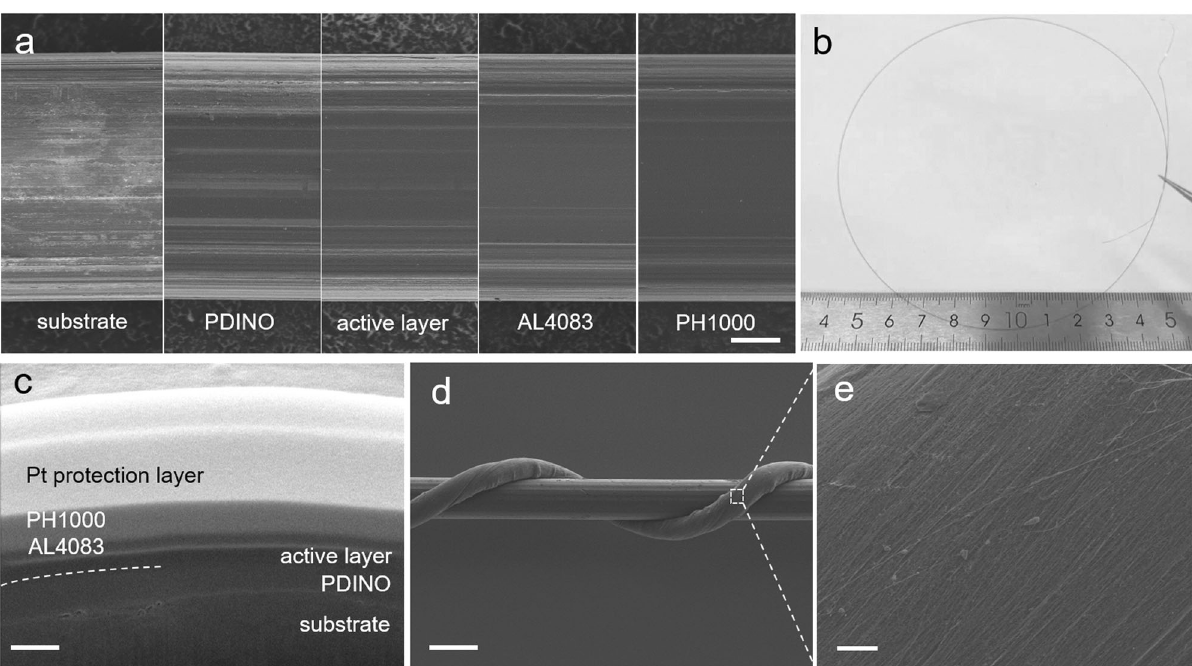
Fig. 2 Characterization of the functional materials for FOSCs. a Surface morphology of each function layer. b Full view image and c cross- sectional SEM image of the multi-layer fi lm coated on primary electrode. d SEM image of the complete FOSC device. e Enlarged view of the CNT yarn counter electrode. The scale bars are 20 μ m, 300 nm, 100 μ m, and 5 μ m in a , c , d , and e ,